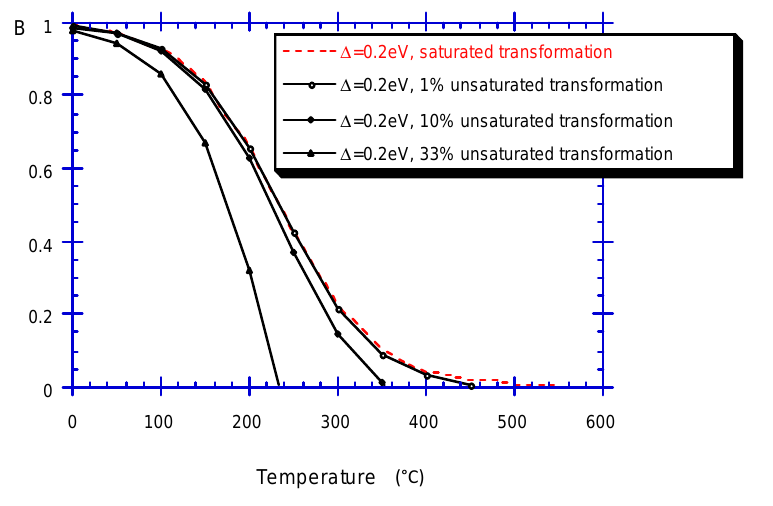
Figure 28. The unsaturated writing leads, in this case, to disymmetrical isochronal curves.